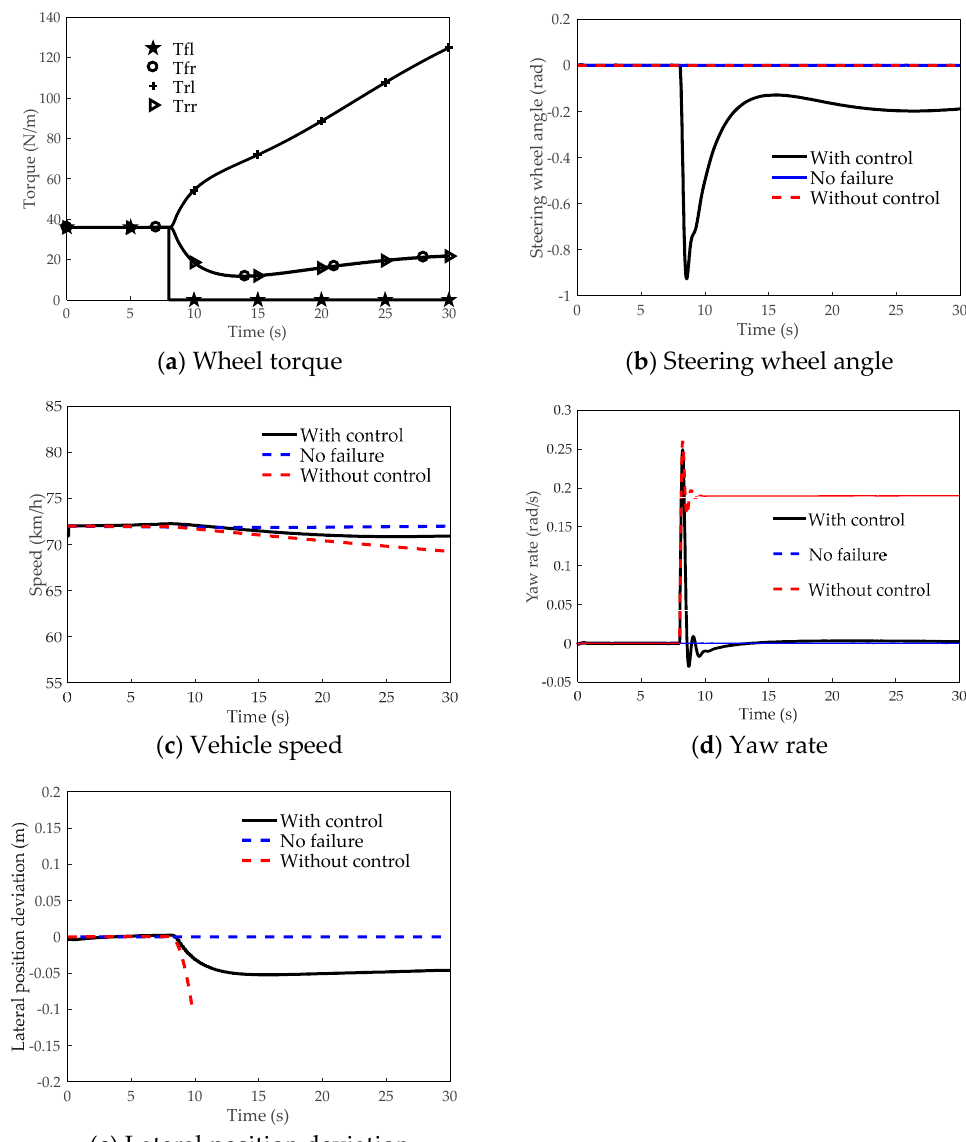
Figure 3. Simulation comparison with/without control under F1 condition. Table 6. Statistical control effect under F1 condition.